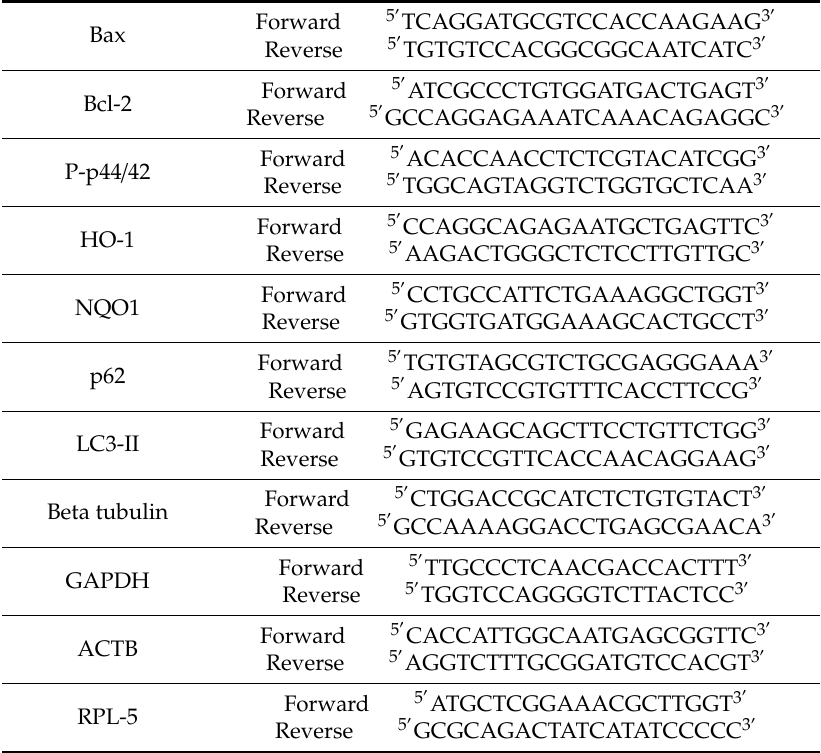
Table 2. Primers used for qPCR